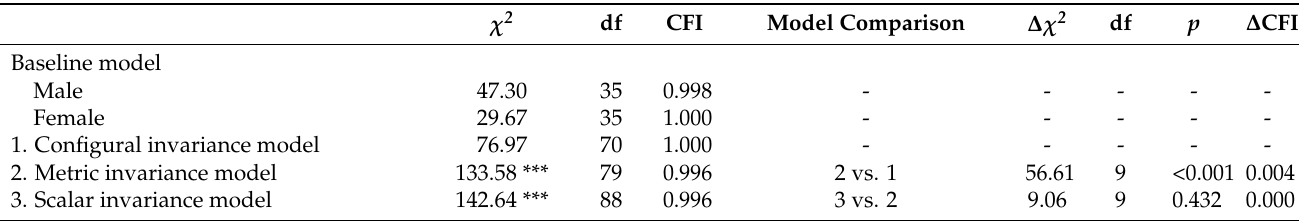
Table 2. Goodness-of-fit Indices for Tests of Invariance of Body Appreciation